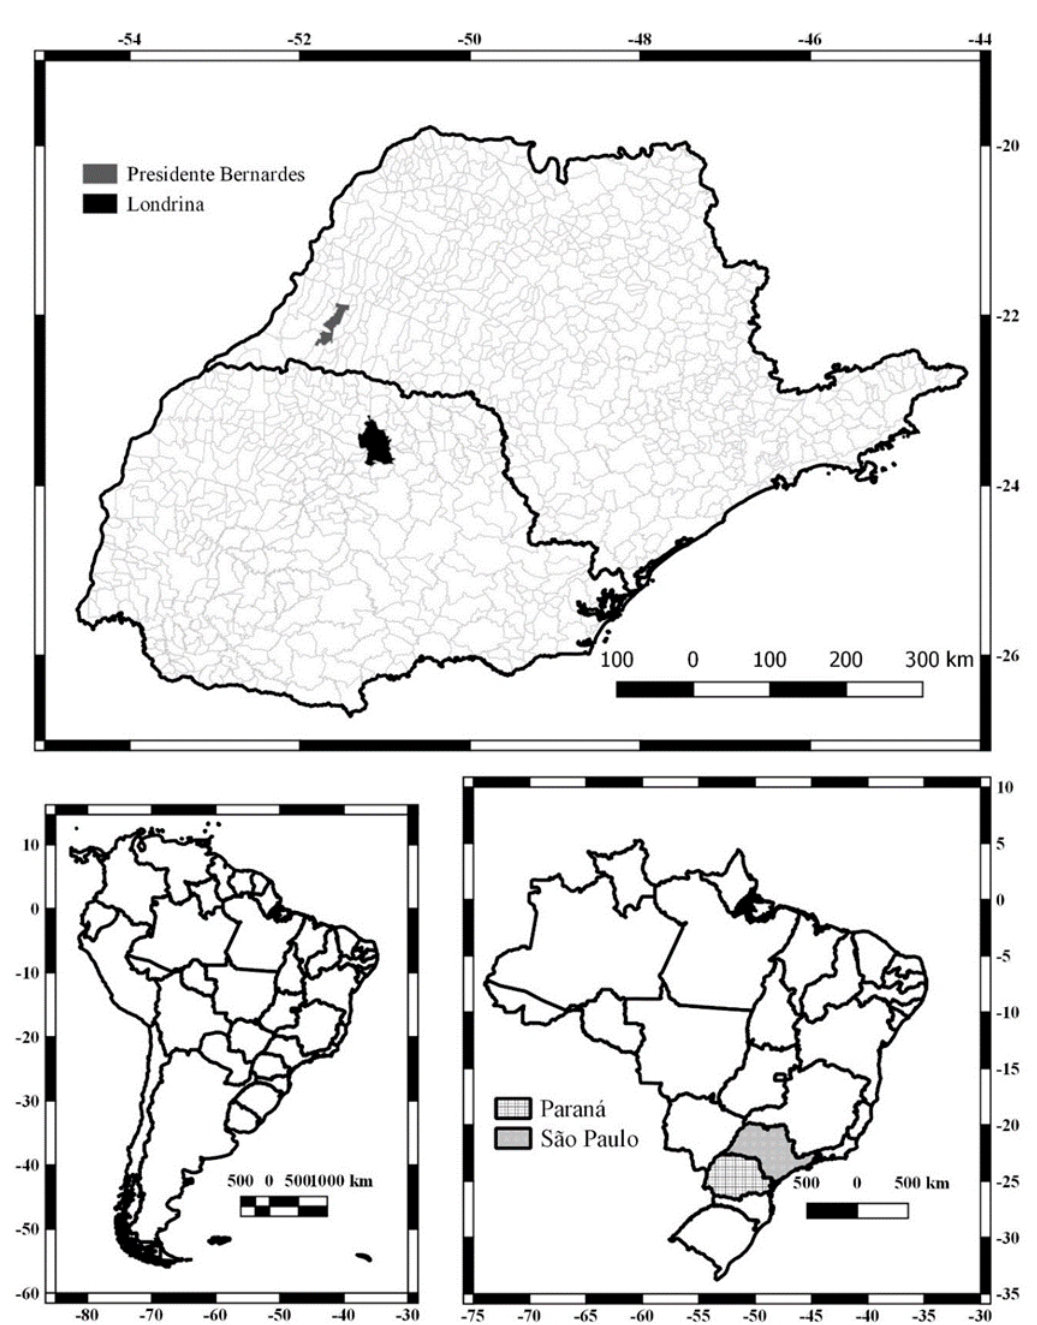
Figure 1. Location of Londrina and Presidente Bernardes Municipalities in the context of Parana and Sao Paulo States, Brazil and South America.